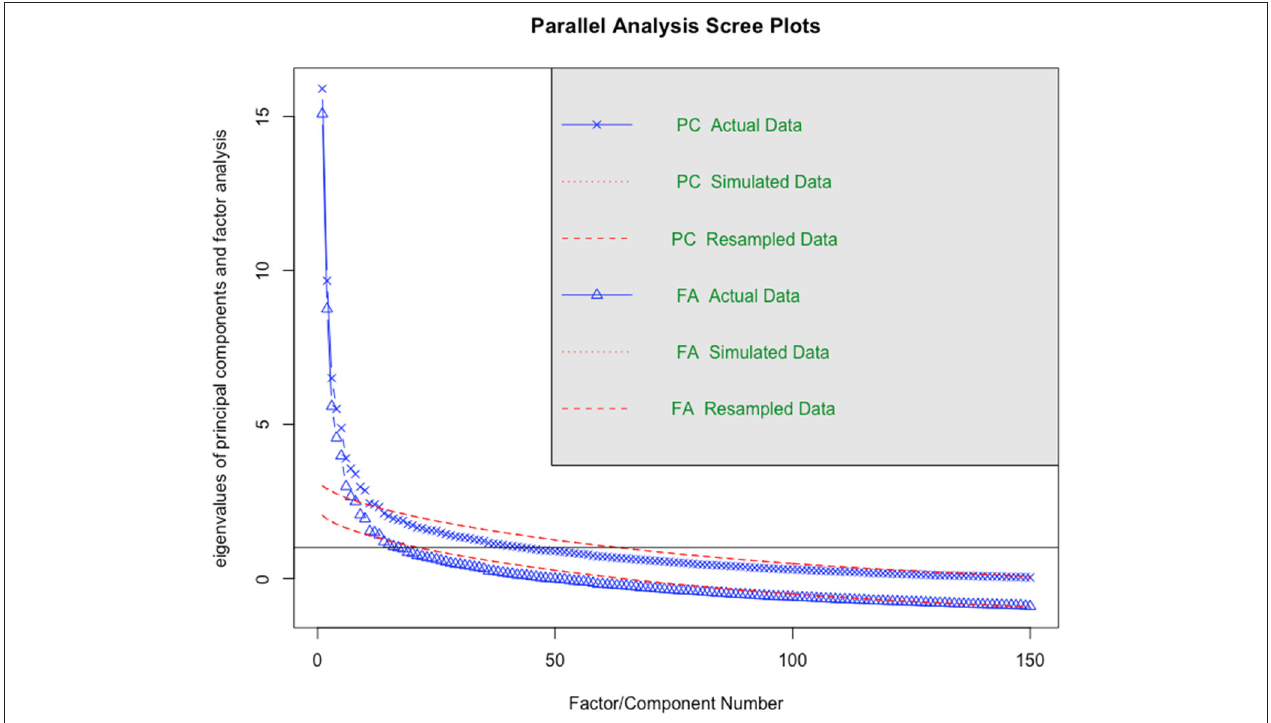
FIGURE 1 | Scree plot